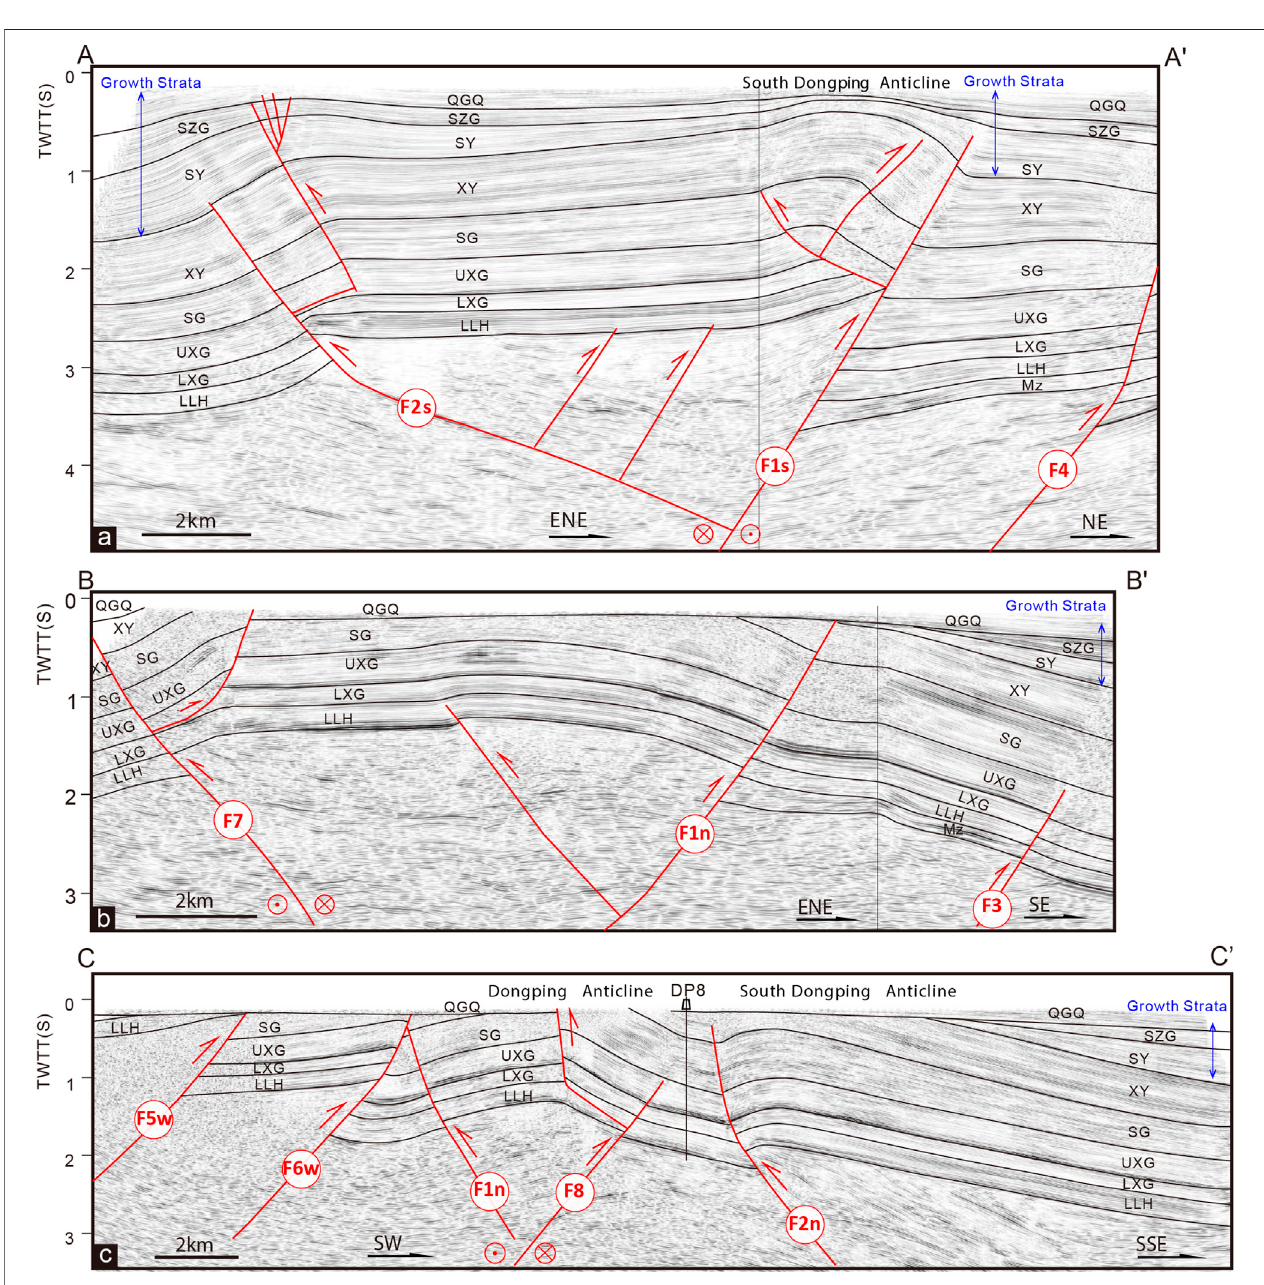
FIGURE4| Three seismicreflectionsectionsacrossmajorfaults inthestudyregion.Thelocationisshownin Figure3 .MzrepresentstheMesozoic(mainly Middle Jurassic). Abbreviations for the Cenozoic units are same as those in Table 1 . TWTT, Two-way travel time.